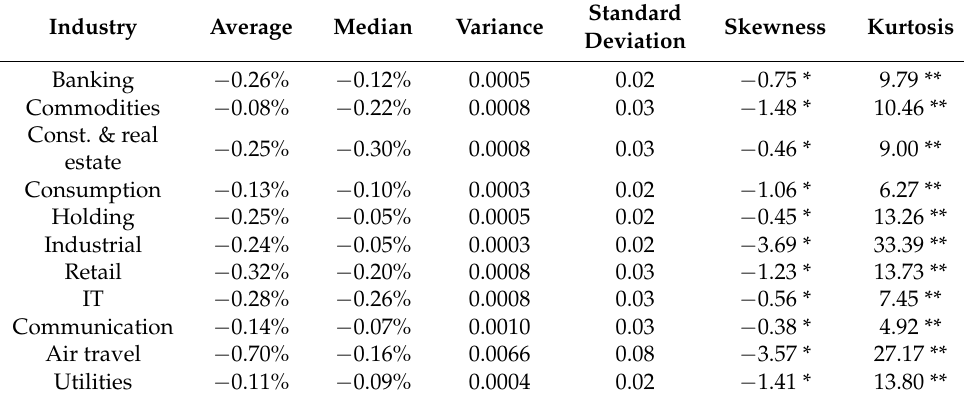
Table 3. Statistical data from the return series used in this study.